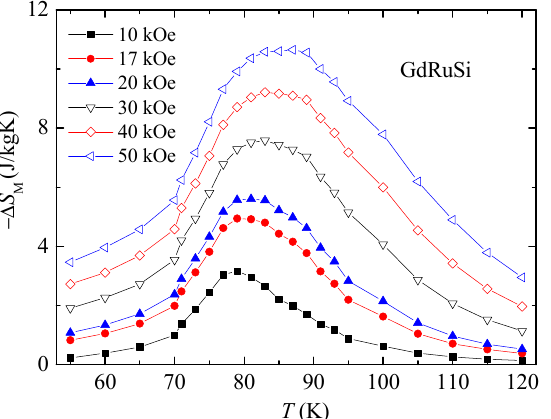
Figure 5. Magnetization isotherms M(H) of GdRuSi in the range T = 50–120 K (up-down). The temperature step is 5 K in the ranges 50–70, 95–120 K and 2 K in the range 71–95 K. Different colors for different symbols are made to better distinguish them.